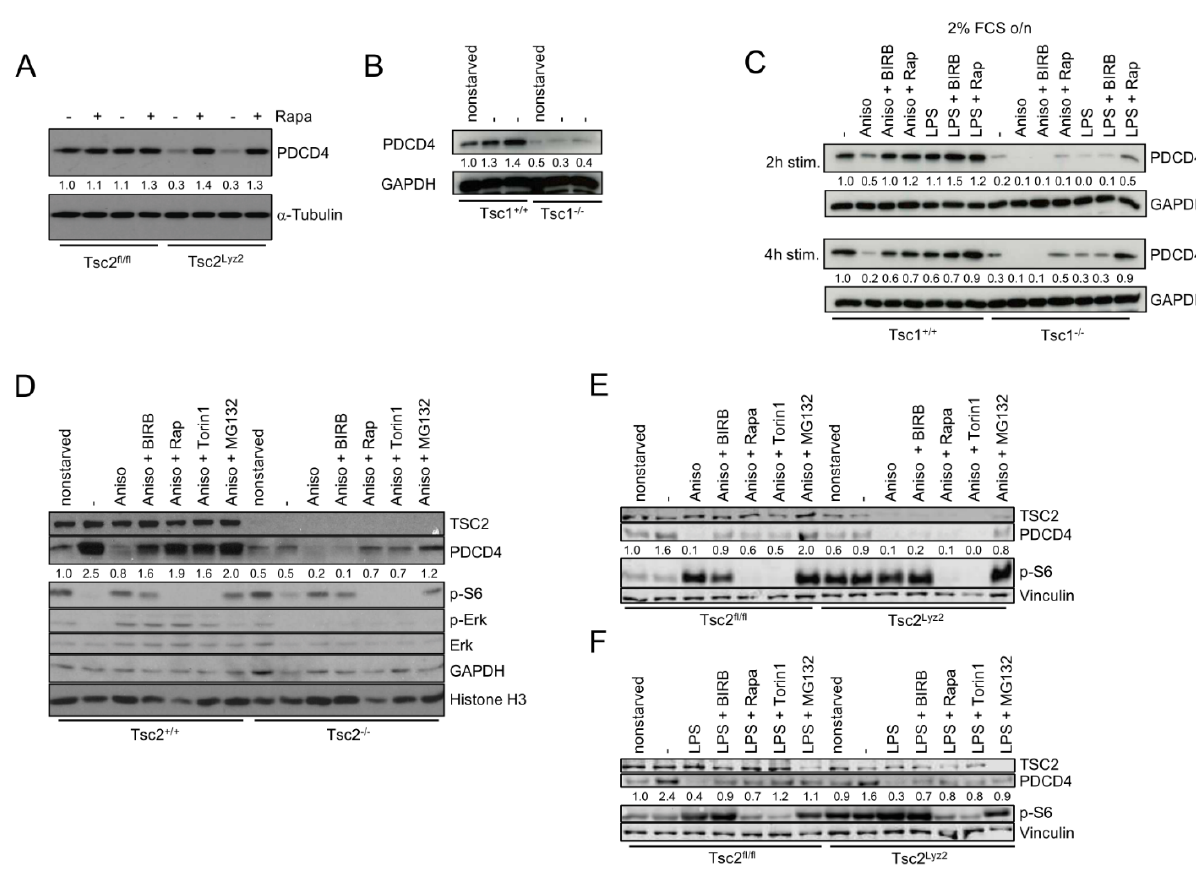
FIGURE 2: The TSC complex links p38 to PDCD4. (A) BMDMs from Tsc2 fl/fl and Tsc2 Lyz2 were cultivated with or without rapamycin for 12 hours. (B) Tsc1 +/+ and Tsc1 -/- fibroblasts were non-starved or serum-starved as indicated and subsequently, cell lysates were prepared. (C) Tsc1 +/+ and Tsc1 -/- fibroblasts were serum-starved overnight. Afterwards, cells were treated with the indicated inhibitors for 90 minutes fol- lowed by Aniso stimulation for 2 and 4 hours, respectively. (D) Tsc2 +/+ and Tsc2 -/- fibroblasts were non-starved where indicated or were se- rum-starved overnight. Inhibitor treatment of cells for 90 minutes preceded 4 hours of Aniso treatment. Cell lysates were analyzed by im- munoblotting. (E, F) BMDMs from Tsc2 fl/fl and Tsc2 Lyz2 mice were pretreated with the inhibitors BIRB796, rapamycin, Torin 1 or MG-132 for 90 minutes and subsequently elicited with LPS or Aniso for 4